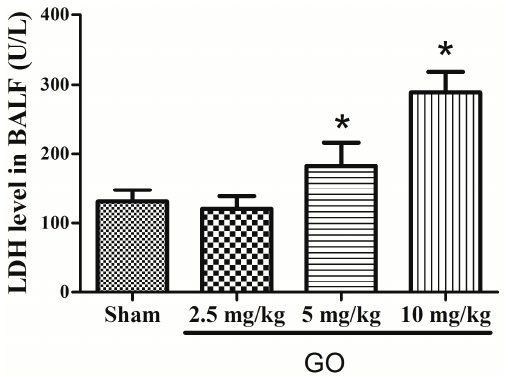
Figure 4. GO induces LDH in bronchoalveolar lavage fluid (BALF). LDH was greater after GO (10 mg/kg) treatment compared to controls but lower doses of GO were not different than controls. * p < 0.05 compared with groups, n =